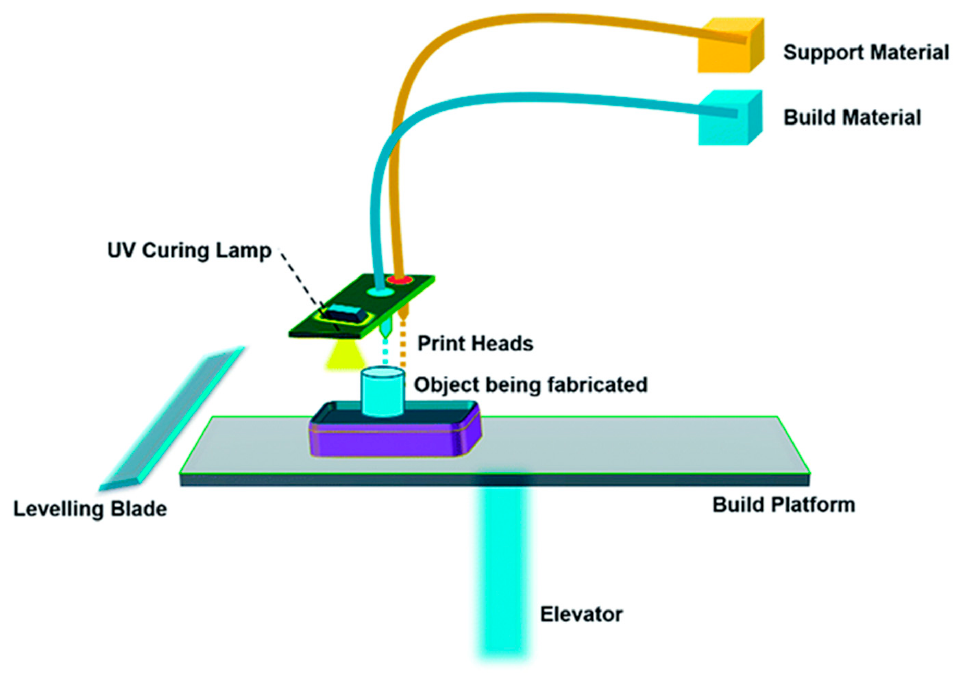
Figure 2. Schematic representation of the material jetting process. Reproduced from Ref. [46]. with permission from the Royal Society of